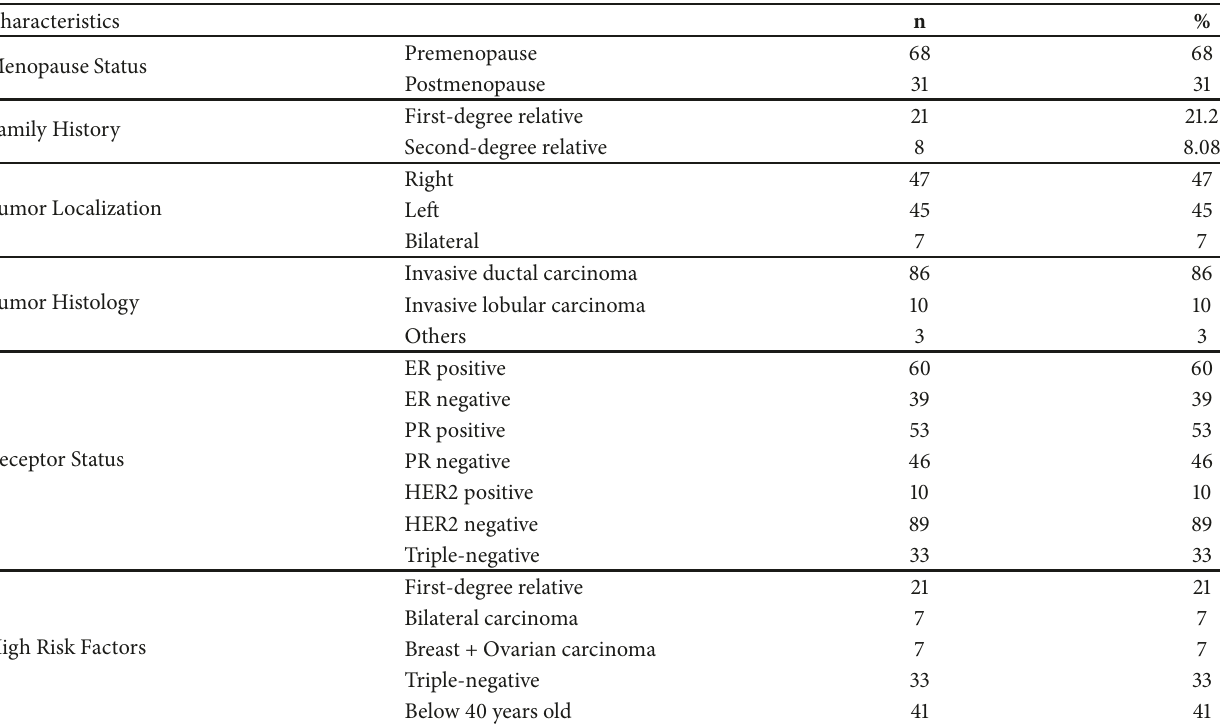
Table 1: The characteristics of the patients.